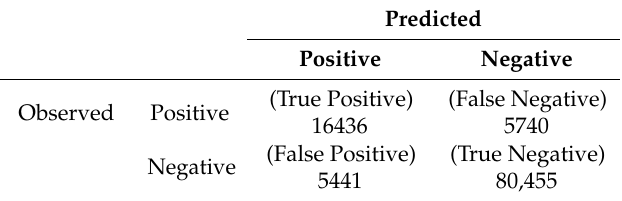
Table 9. Results of algorithm performance evaluation at single image level: raw